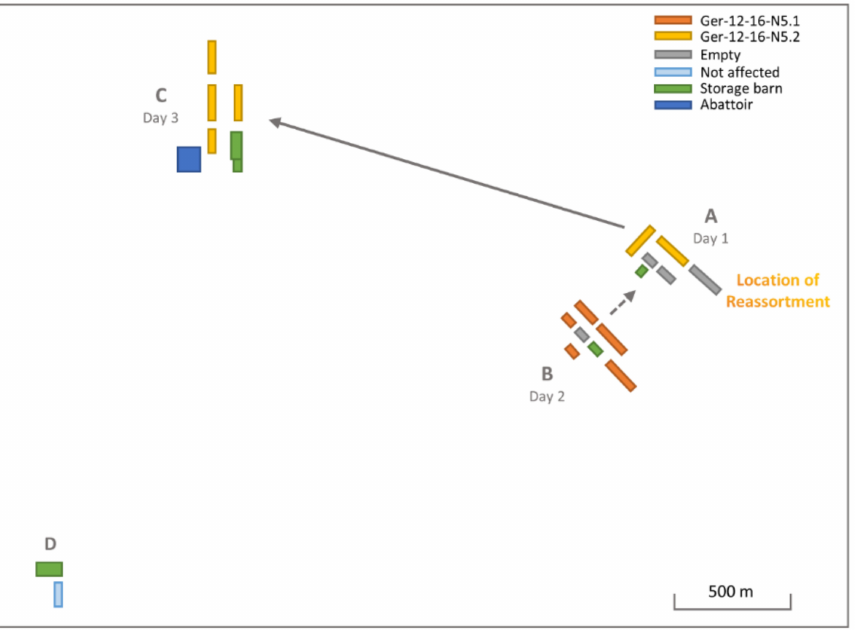
Figure 3. Schematic representation of the H5N5-infected poultry holding (Ger-12-16-N5.1—orange, Ger-12-16-N5.2—yellow) with view of the individual locations (A–D). Buildings are colored ac- cording to usage, dotted line indicates potential carryover and reassortment between locations, and continuous line represents definite carryover between buildings A and C. Location D was not